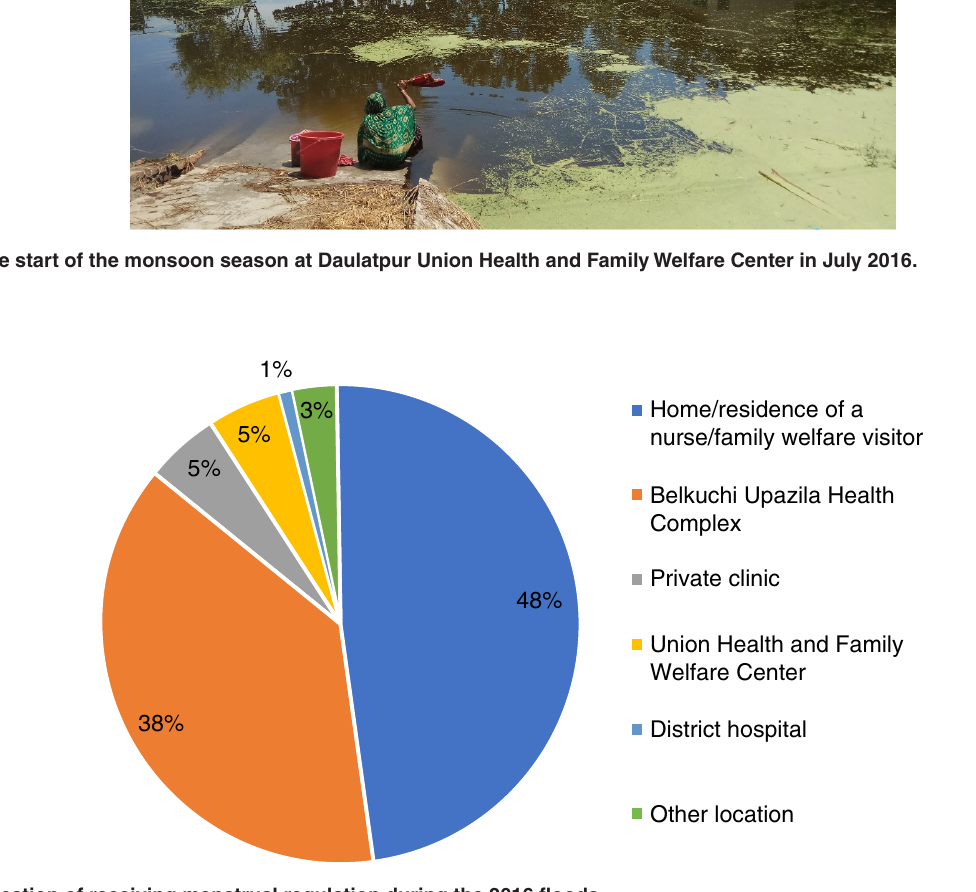
Figure 3. Location of receiving menstrual regulation during the 2016